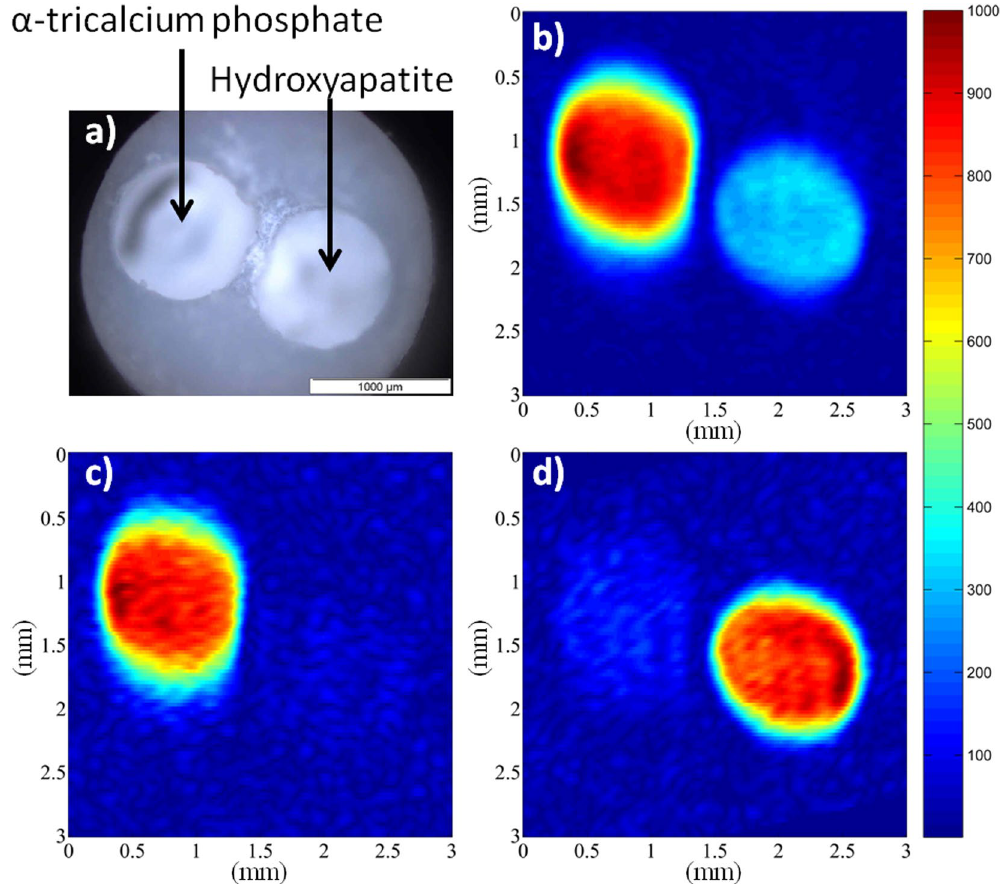
Figure 4. ( a ) Picture (top view) of the phantom made of a PTFE insert with two cylindrical boreholes parallel to the spinning axis (1 mm in diameter) filled with HA and α -TCP powders. ( b ) 31 P 2D MAS MR image of the phantom (projection along the z MAS axis) recorded with direct 31 P single pulse excitation and TR = 360 s. ( c ) 31 P 2D MAS selective image of the α -TCP phase, recorded with a 31 P saturation comb and TR = 2 s. ( d ) 31 P 2D CP MAS selective image of the HA phase, obtained using a CP time of 3 ms and TR = 1 s. The nominal spatial resolution for all images is 52 µ m in the read dimension and 121 µ m in the phase dimension (FOV = 3 × 3 mm 2 ). 16 transients were co-added corresponding to an experimental time of ( b ) 51.2 hours, ( c ) 17 min and d) 8 min. The dataset was zero filled four times leading to a pixel size of 6 * 6 µ m 2